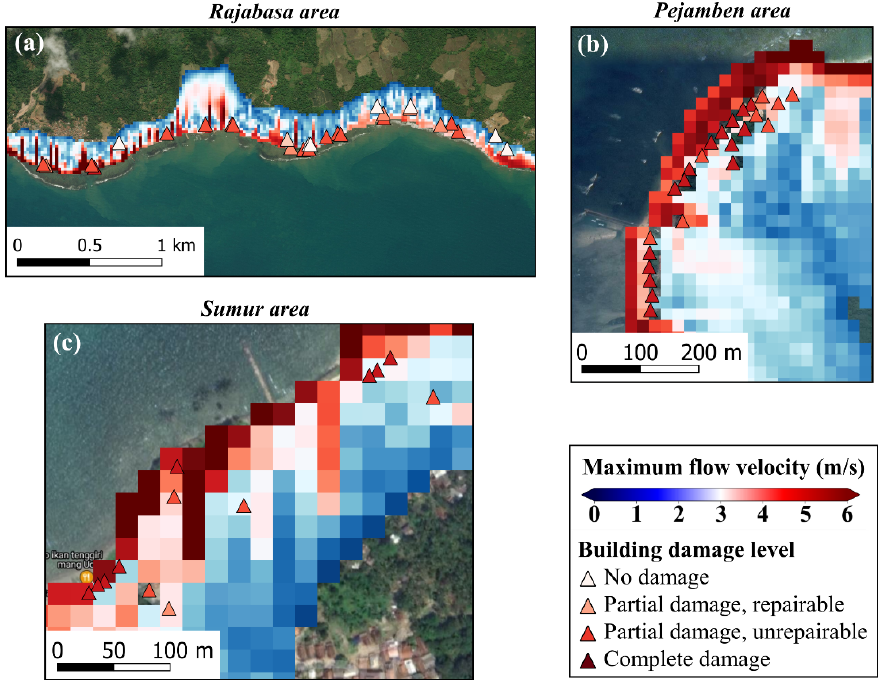
Figure B3. (a–c) Magnified views of the maximum simulated flow velocity of the 2018 Sunda Strait tsunami overlaid on the damaged building data in the Rajabasa, Pejamben, and Sumur areas (background ESRI and © Google